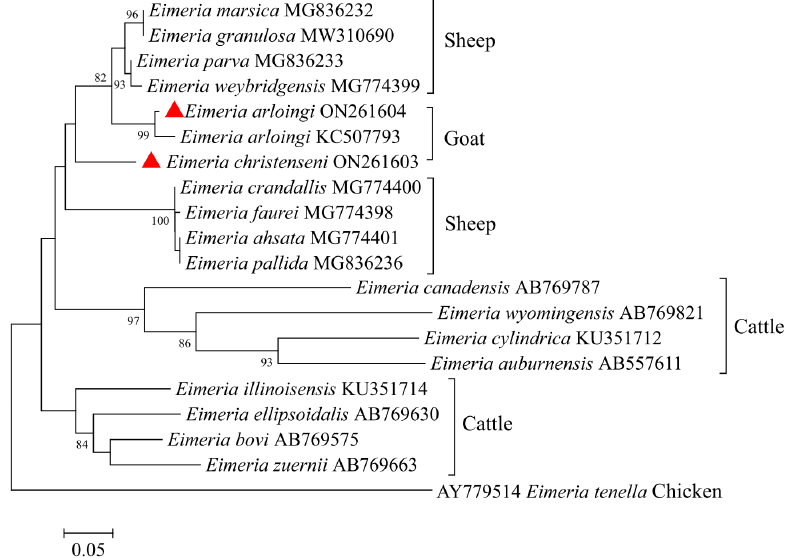
Figure 3. Phylogenetic tree generated by the Neighbor-Joining method using full sequences of the ITS-1 region of E. christenseni and E. arloingi from the present study and representative sequences of other Eimeria species available in GenBank. The sequences obtained in this study are marked with red triangles (bootstrap values below 75% are not indicated).